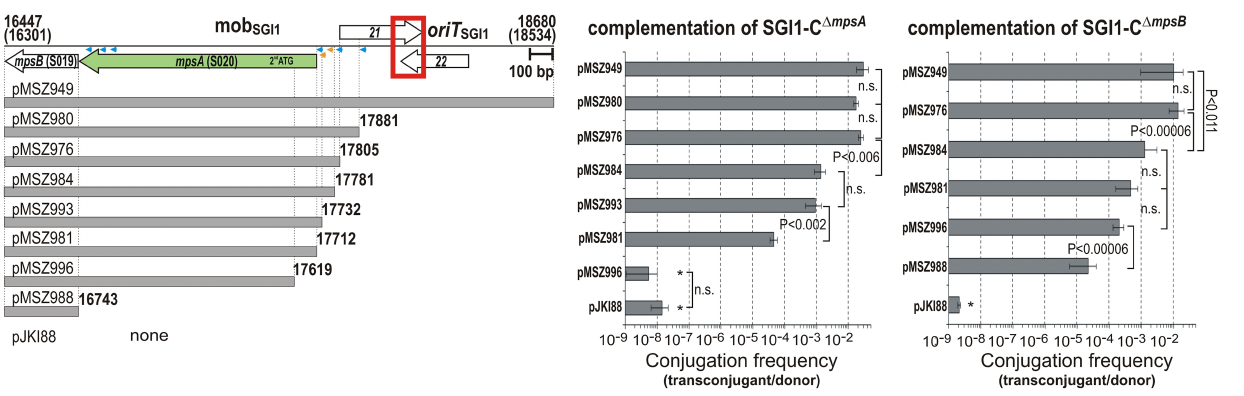
FIGURE 5 | Identification of promoter regions driving expression of mpsA and mpsB . The fragments cloned into the complementing plasmids are shown below the schematic map of mob SGI1 region. Putative promoter elements predicted by BPROM or found by manual search are indicated by blue or yellow arrowheads, respectively. Other symbols are as in Figure 1B . Transfer frequency of SGI1-C (cid:49) S020 and SGI1-C (cid:49) S019 was measured in the presence of one of the complementing plasmids and the helper plasmid R55 (cid:49) Tn 6187 . Plasmid pMSZ984 showed high st. deviations in three independent complementation assays carried out with 3–6 replicates with SGI1-C (cid:49) S019 , thus the complementation efficiency of this plasmid could not exactly be determined. However, mean values appeared similar to that of pMSZ981 and pMSZ996. ∗ Transconjugants resulting from oriT SGI1 -independent transfer pathway.